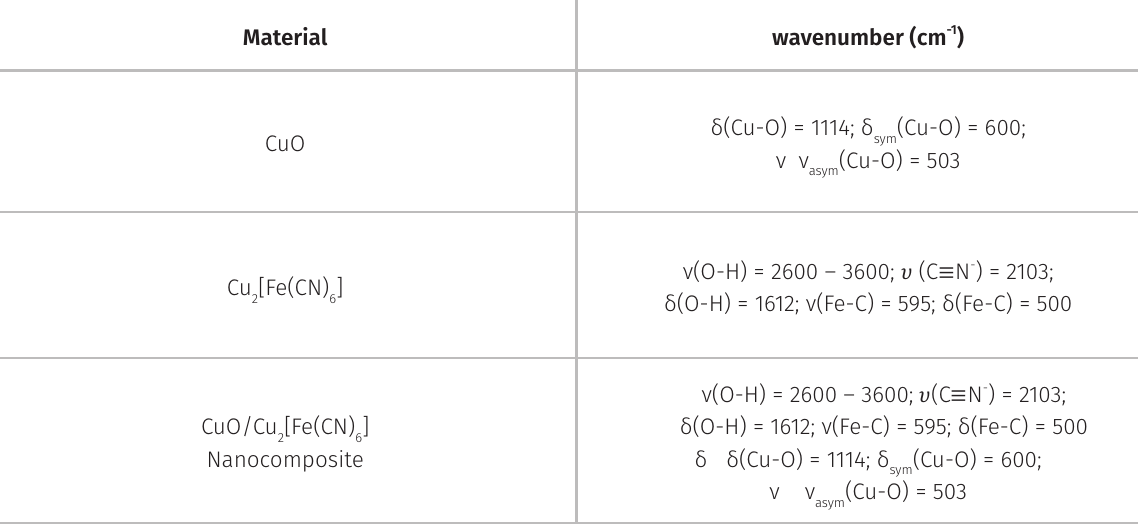
Table I. Assignment of FTIR spectra bands to the CuO, Cu